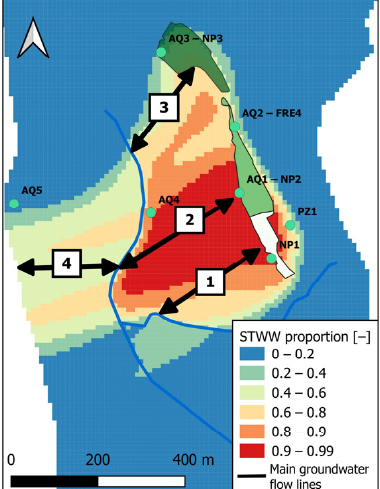
Figure 11. Selection of the main groundwater flow lines for calculating the average velocities between infiltration ponds 1, 2, and 3 and the Goulot, and 4 between the Goulot and the sea. The average flow velocities calculated over all meshes in segments 1, 2, 3, and 4 were 2.5 m/d, 2.7 m/d, 3.0 m/d, and 3.7 m/d, respectively (Figure 12), for the period 2017–2021. The highest velocities were calculated in winter, in February, March, and April (4.6 m/d, 4.7 m/d, 5.5 m/d, and 6.7 m/d, respectively). The values were minimal during